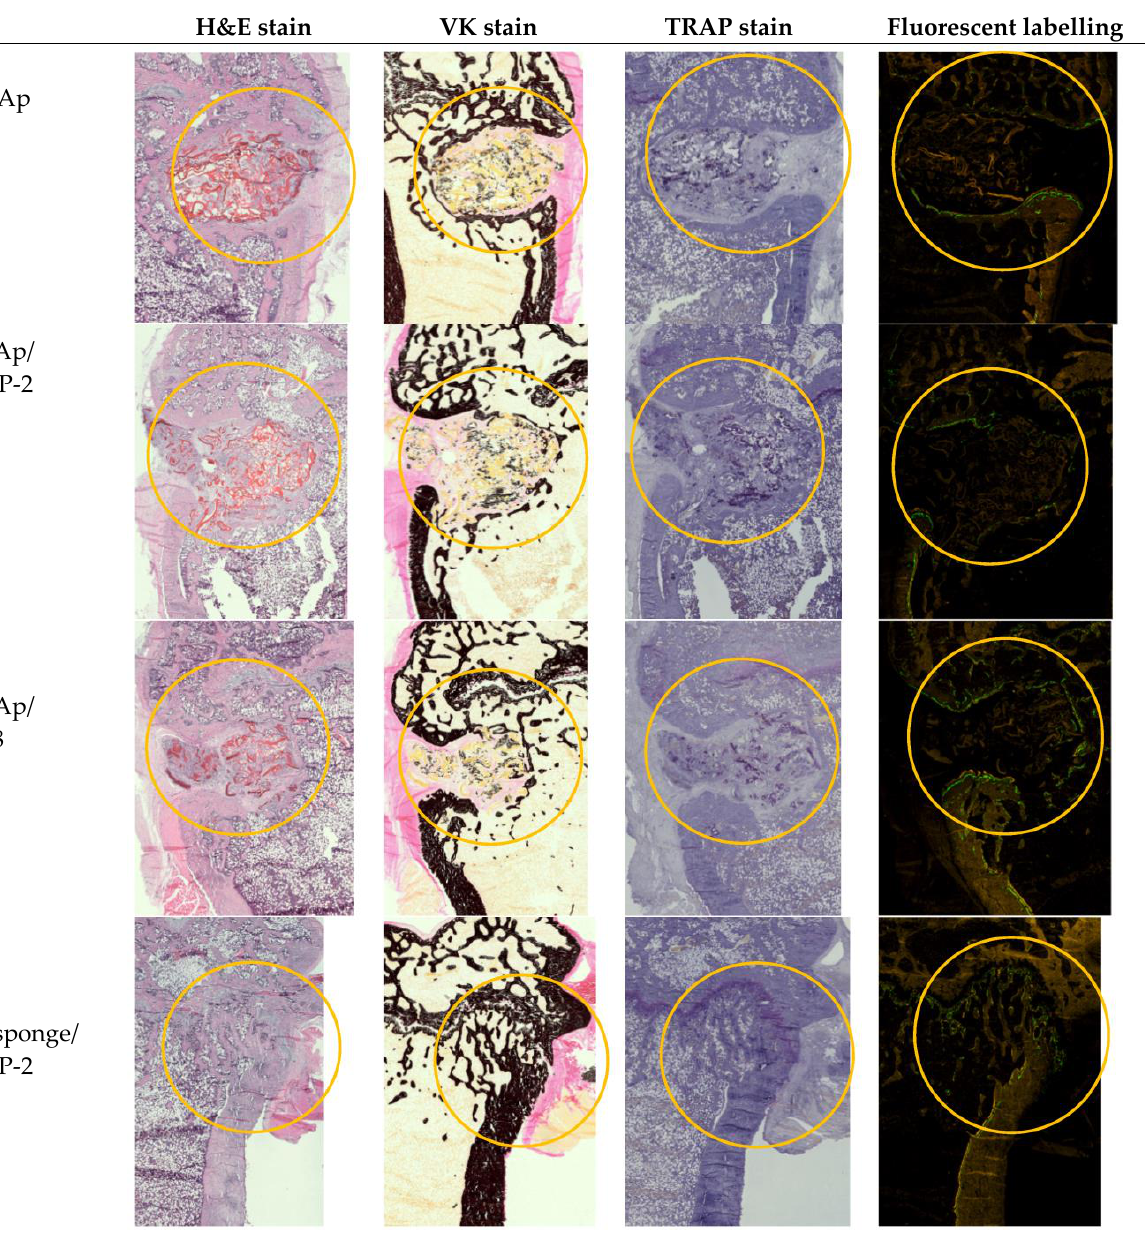
Figure 10. An overview of the HE, VK and TRAP staining as well as the calcein and xylenol fluorescent labelling on the femoral condyles after eight weeks of healing. Observing the defect closure, the CS/HAp/P28 scaffolds presented better bone healing compared to CS/HAp and CS/HAp/rhBMP-2. (Annotation: Yellow circle= Implantation site)